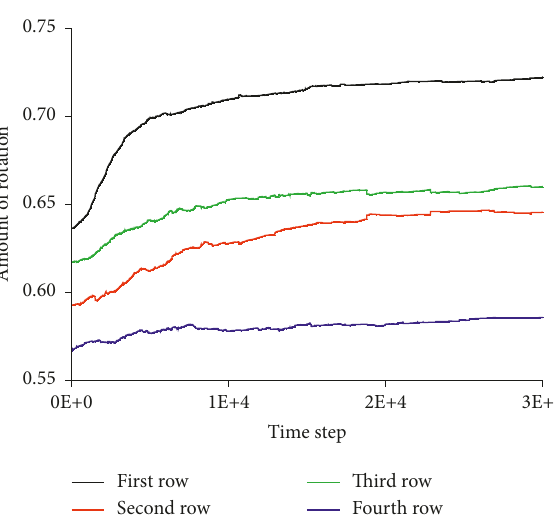
Figure 24: Rotation variation of particle above the plate.